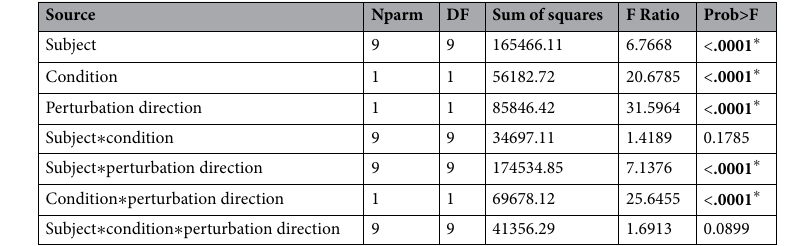
Table 3. The main and interaction effects of the factors. Significance values are in